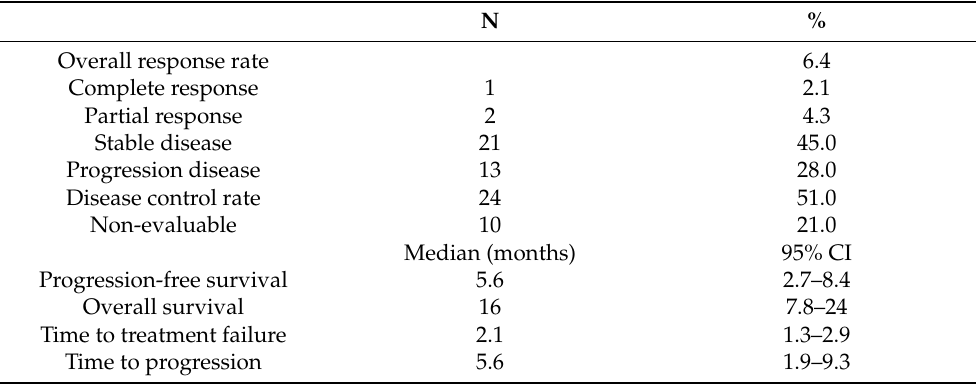
Table 3. Patients’ treatment response classification. Classification and percentage of patients’ response to regorafenib treatment. Data regarding progression and survival based on RECIST v1.1 criteria are also shown.